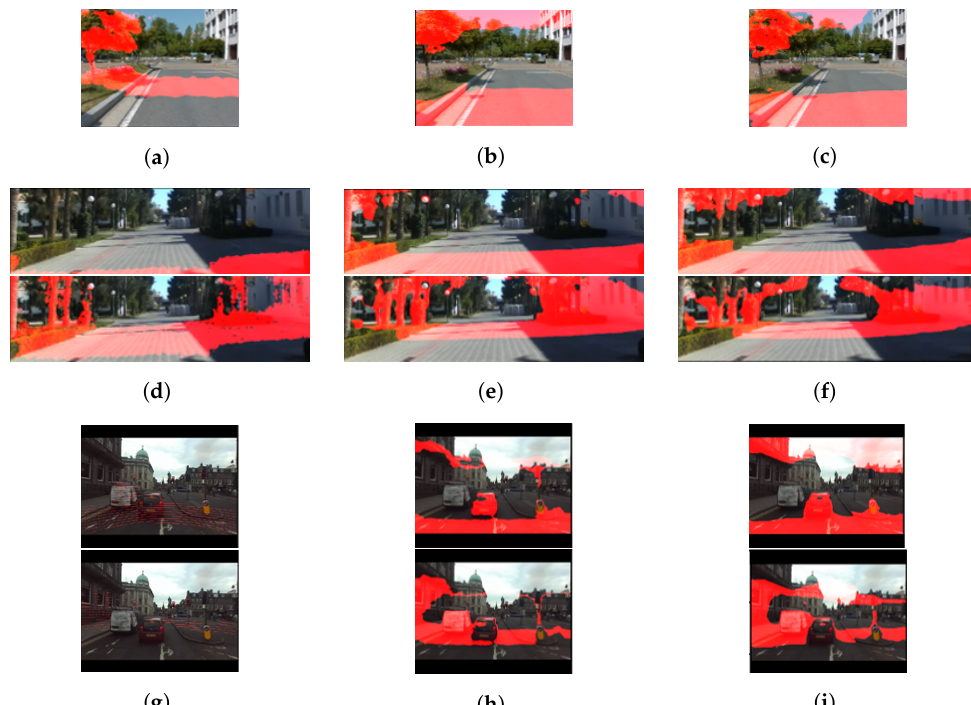
Figure 2. Results of using the models (BTS, AdaBins) trained with the KITTI training dataset for depth estimation of other datasets (from left to right: ground truth, BTS depth result, AdaBins estimation result). The red dots and regions in the ground truth indicates a point group existing in the depth estimation range of the stereo camera used to collect the dataset. The red regions in the BTS and AdaBins depth estimation results indicate the point groups corresponding to depth ranges. ( a – c ) CNU dataset (5 to 10 m), ( d – f ) UASOL dataset (upper: 5 to 10 m; lower: 10 to 20 m), ( g – i ) RADIATE dataset. (upper: 5 to 10 m; lower: 10 to 20